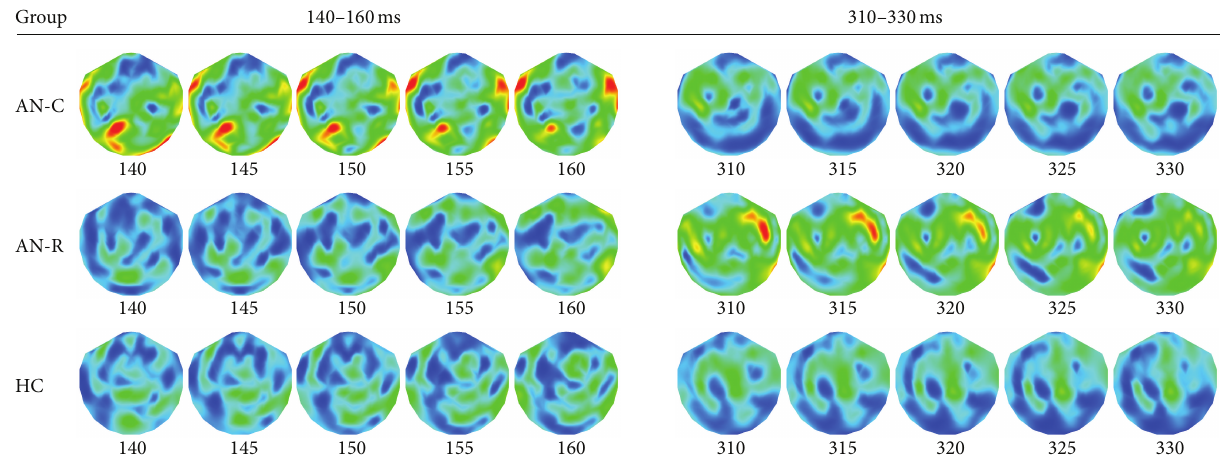
Figure 3: Mean amplitude of neural activity (ft/cm) for the two peak times of interest shown in sensor space (gradiometers) for each experimental group. Neural activity is shown with 10 milliseconds either side of the 150 and 320 milliseconds peaks after stimulus (all food pictures versus baseline). The scale used was 0–5 ft/cm with the exception of the 310–330 milliseconds’ time period in the AN-R group, for which a scale of 0–3 ft/cm was used for visualisation purposes. AN-C: acute Anorexia Nervosa group, AN-R: recovered Anorexia Nervosa group, and HC: healthy control group.